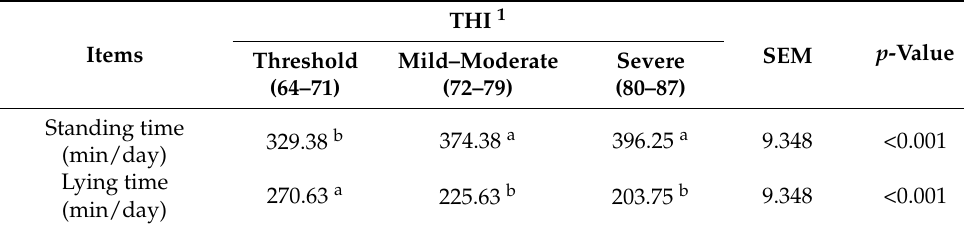
Table 5. Effect of heat stress level on behavioral patterns in Korean native beef